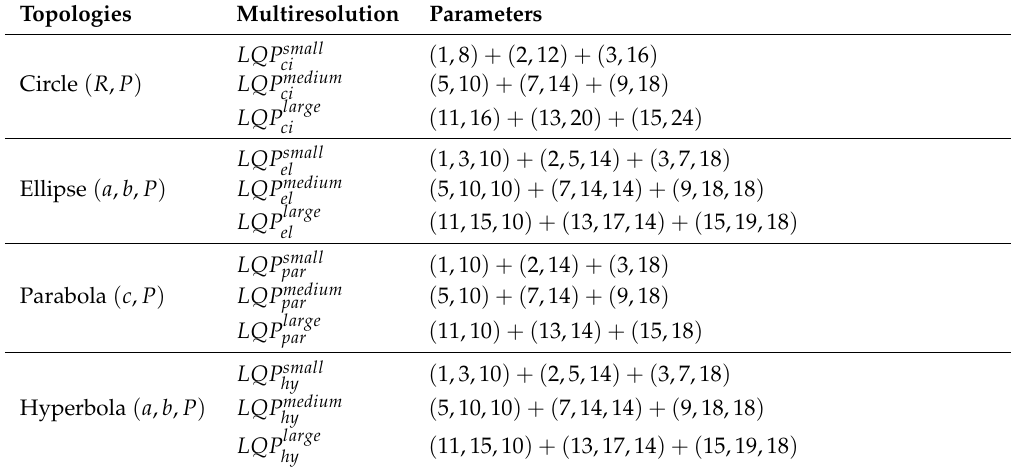
Table 2. Parameters values for different multiresolutions on different neighbourhood